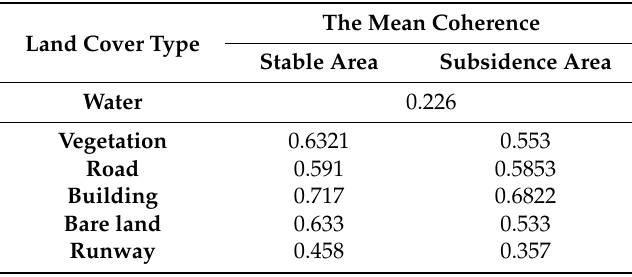
Table 1. The mean coherence for each land cover type in the stable area and subsidence area.